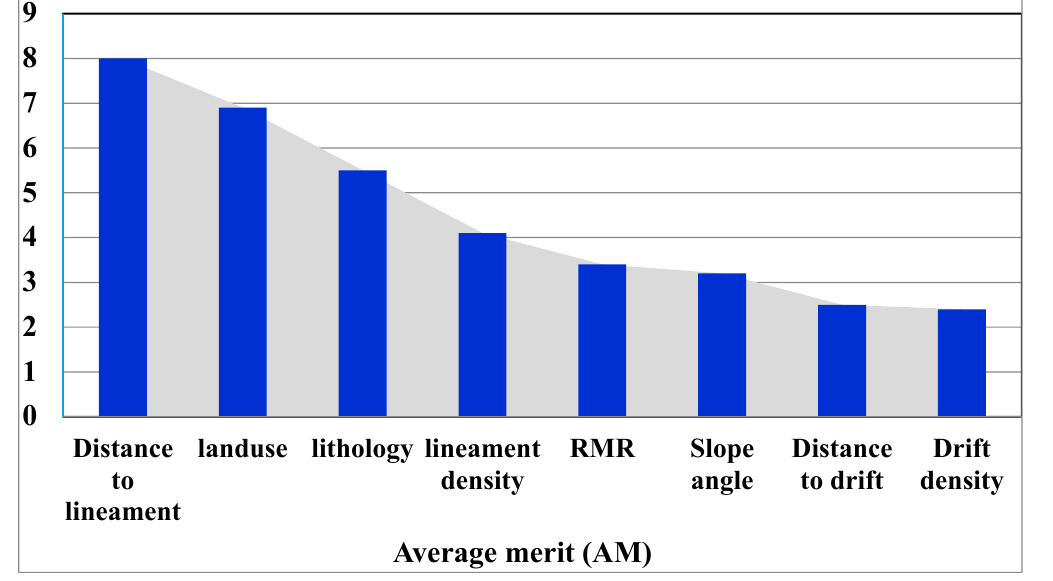
Figure 3. Prediction capability of the most important land subsidence conditioning factors for land subsidence modelling.